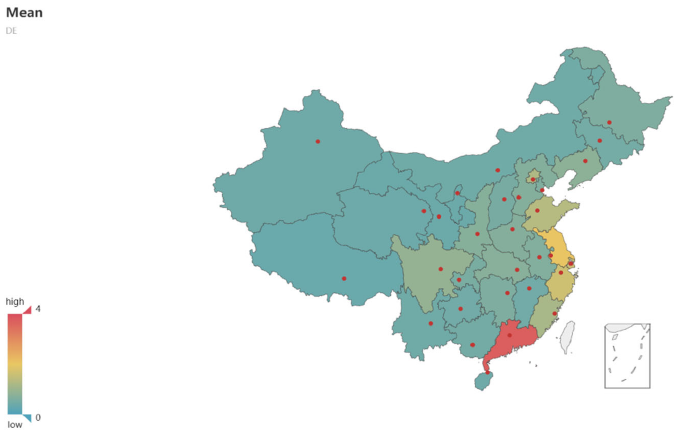
Figure 2. Geographical map of the mean value of digital economic development in the 31 provinces of China from 2009 to 2018.